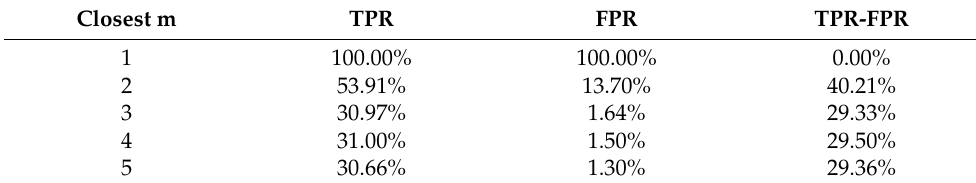
Table 2. Comparison on TPR, FPR and their difference for several choices of the L P list. Closest m TPR FPR TPR-FPR